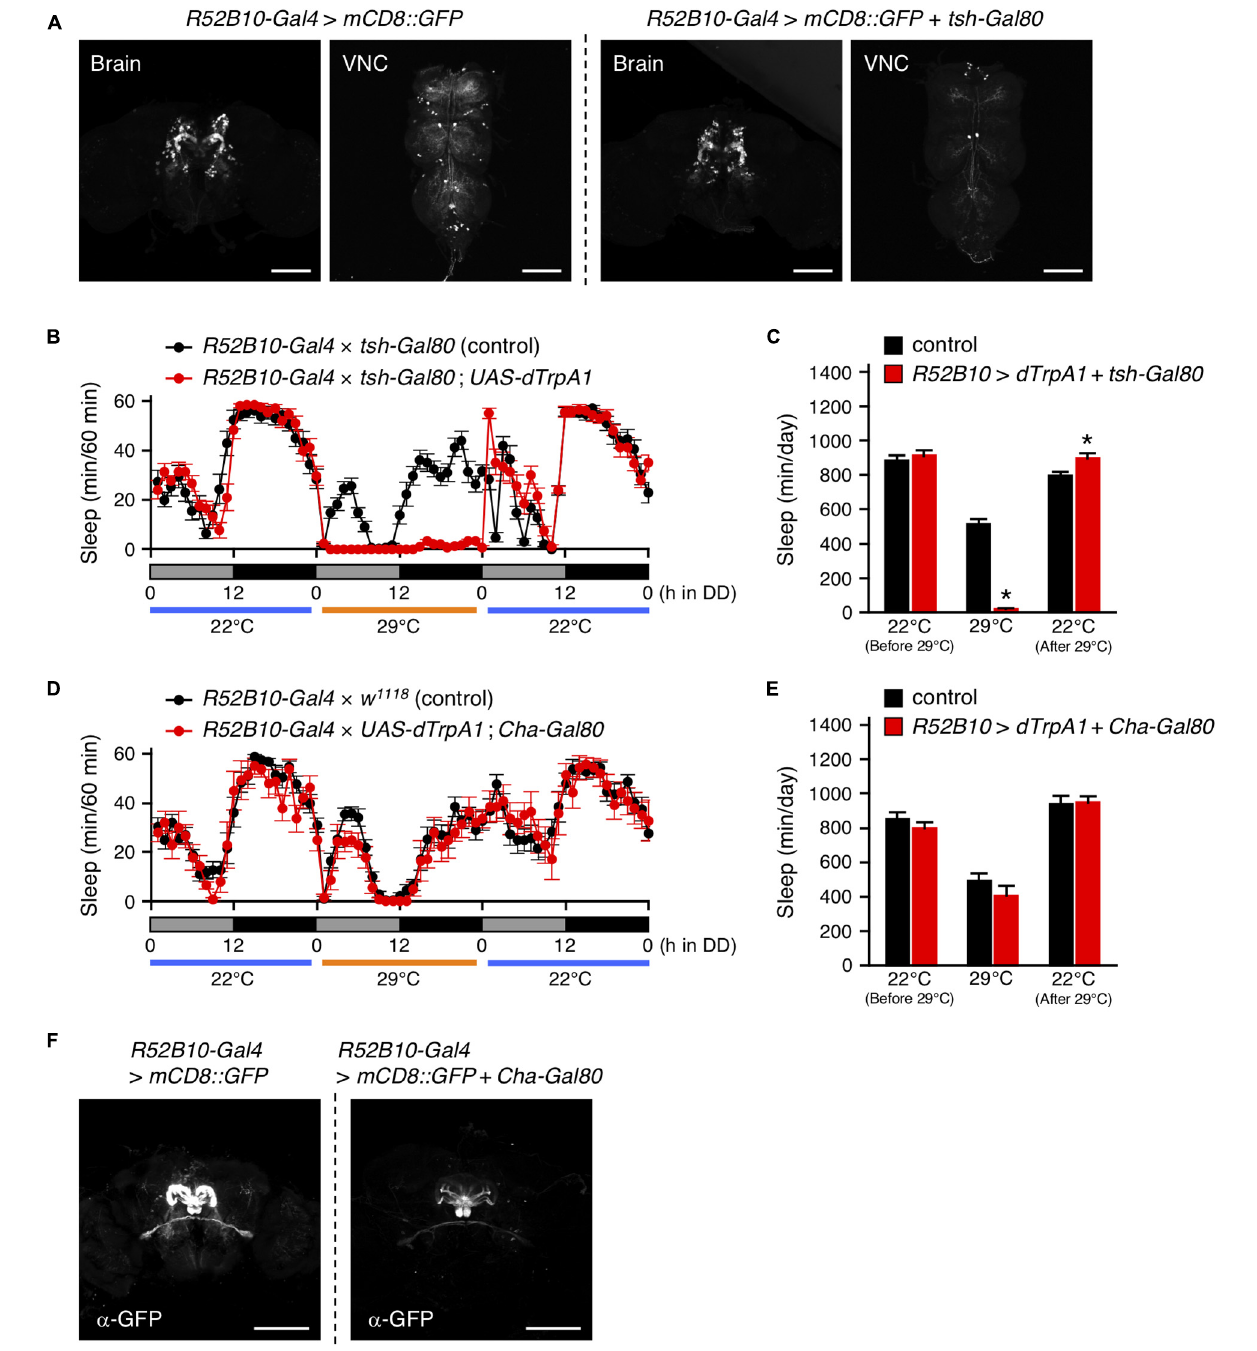
FIGURE 4 | Activation of R52B10-Gal4 -expressing cholinergic neurons in the brain promotes wakefulness. (A) Maximum-intensity projection of the confocal brain or VNC images of flies expressing UAS-mCD8::GFP under the control of R52B10-Gal4 (left two panels) or R52B10-Gal4 with tsh-Gal80 (right two panels). The tsh - Gal80 efficiently suppressed R52B10-Gal4 driven GFP expression in the VNC, while did not in the brains. Scale bars represent 100 µ m. (B,C) Sleep profiles in 60-min intervals (B) or total daily sleep (C) for control flies ( R52B10-Gal4 × tsh-Gal80 , black circles or bars, n = 16) or flies expressing dTrpA1 in R52B10-Gal4 brain neurons ( R52B10-Gal4 × tsh-Gal80 ; UAS-dTrpA1 , red circles or bars, n = 16) in DD. The behavior was monitored as described in Figure 2 . Data are presented as mean ± SEM. * p < 0.05 vs. control; two-way repeated measures ANOVA followed by simple main effect test. (D,E) Sleep profiles in 60-min intervals (D) or total daily sleep (E) for control flies ( R52B10-Gal4 × w 1118 , black circles or bars, n = 16) or flies expressing dTrpA1 in R52B10-Gal4 except for cholinergic neurons ( R52B10-Gal4 × UAS-dTrpA1 ; Cha-Gal80 , red circles or bars, n = 7) in DD. Data are presented as mean ± SEM. (F) Maximum-intensity projection of the confocal brain images of flies expressing UAS-mCD8::GFP under the control of R52B10-Gal4 (left panel) or R52B10-Gal4 with Cha-Gal80 (right panel). Scale bars represent 100 µ m.